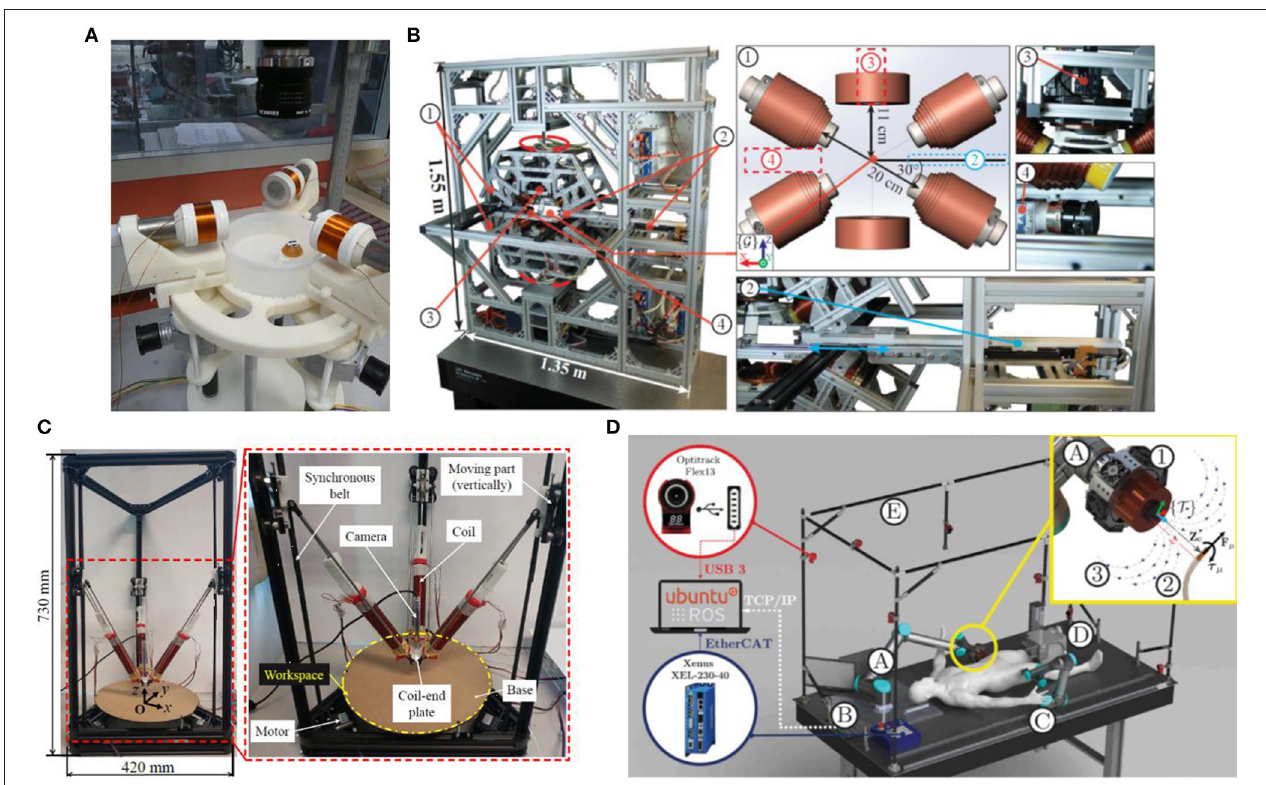
FIGURE 7 | (A) A magnetic system consisting of 3 hollow-core coils that can rotate around their respective vertical axes (Véron et al., 2013a) (B) BigMag control system, including three movable and three stationary electromagnetic coils ( Sikorski et al., 2017) (C) DeltaMag control system, including three symmetrically distributed moving coils ( Yang et al., 2019); (D) ARMM control system in which a single cored coil is moved by a mechanical arm with 6-DOF (Sikorski et al.,